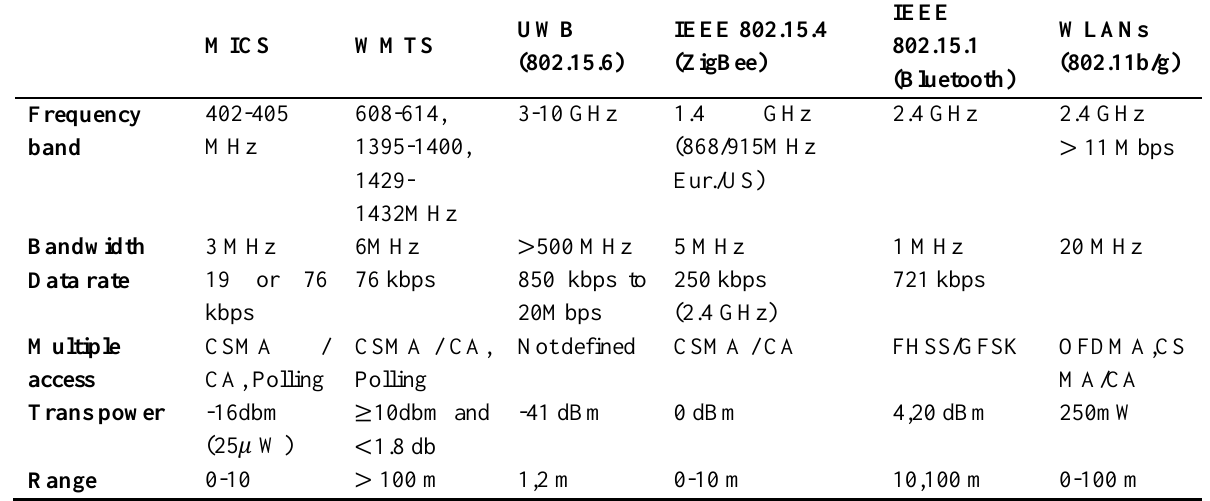
Table 5. Wireless technologies used in medical monitoring